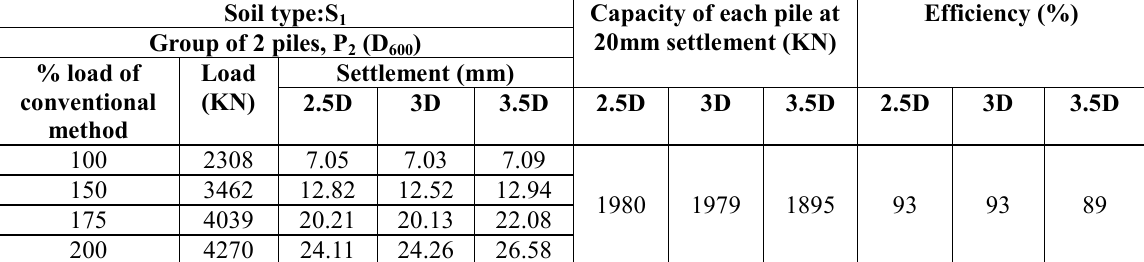
Settlement of P piles of D under different loads to find efficiency. [Hardening Soil Model]. 2 600 Soil type:S